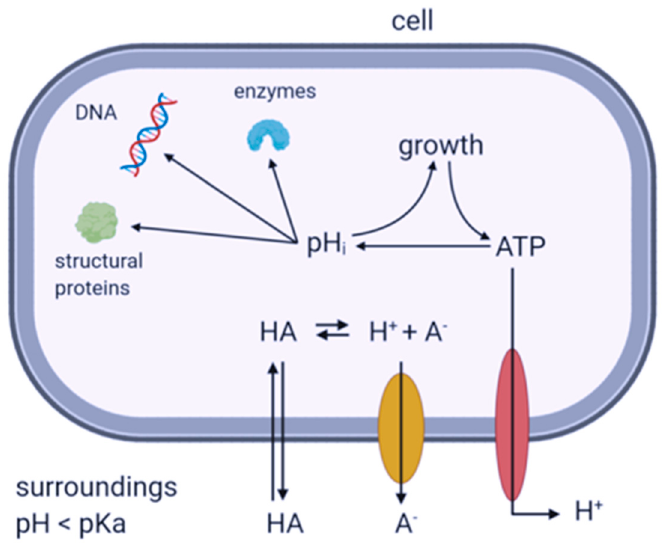
Figure 3. Mechanism of weak organic acids such as lactic acid on bacterial cells. The undissociated form of organic acids (HA) can cross cell membranes when the pH of the surroundings is lower than that of the cellular cytoplasm. Inside the cell, HA can dissociate and acidify the cytoplasm. Acidic pH damages or modifies internal structures such as enzymes, structural proteins, or DNA. In order to control internal pH, energy is required for active export of protons. The figure was adapted from [34] and created in BioRender.com.